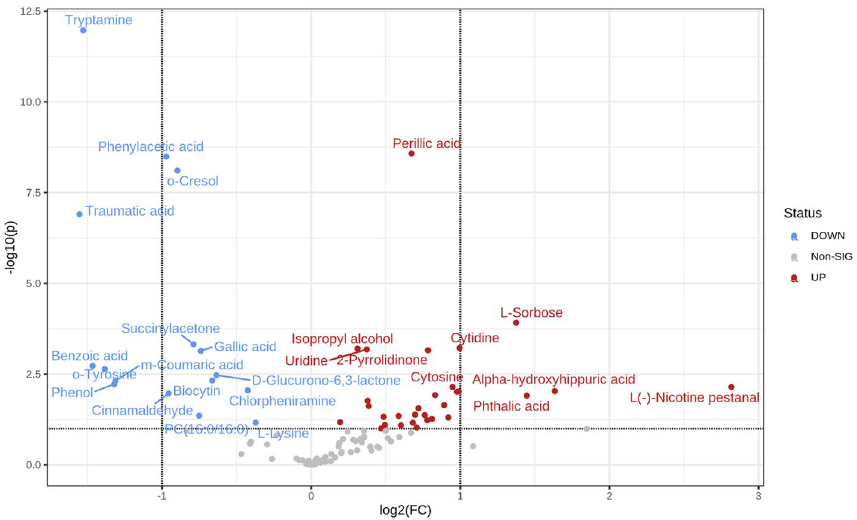
Figure 3. Volcano plot representing the metabolomics comparison between medwakh smokers and non- smokers. Most abundant and significantly altered metabolites in medwakh smokers are highlighted in red color whereas less abundant metabolites are shown in blue color.